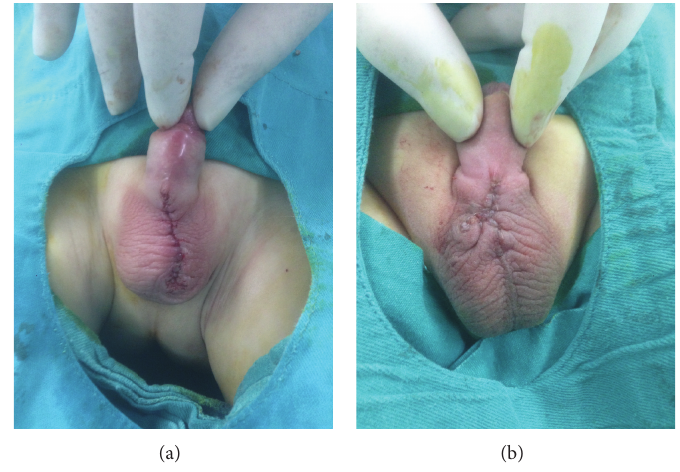
Figure 2: (a) Appearances of case 1 and (b) case 2 following second